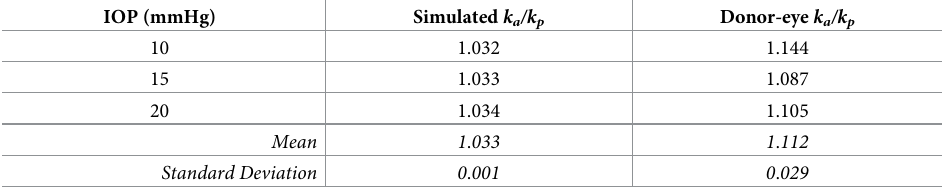
Table 3. Axial stiffness ratio between anterior and posterior corneal regions in response to varying intraocular pressures. IOP (mmHg) Simulated k a /k p Donor-eye k a /k p 10 1.032 1.144 15 1.033 1.087 20 1.034 1.105 Mean 1 . 033 1 . 112 Standard Deviation 0 . 001 0 . 029 IOP: intraocular pressure; k a and k p : slope of the force/displacement function for anterior (a) and posterior (p) corneal stromal